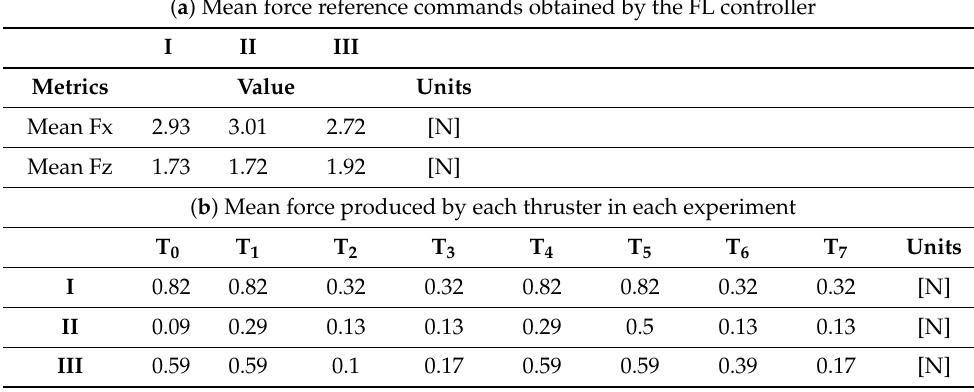
Table 4. Mean force summary.